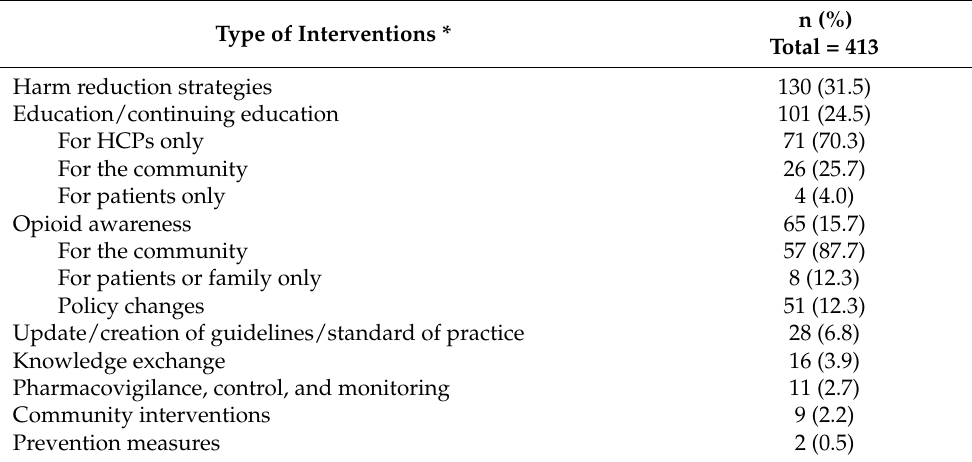
Table 1. Types of opioid risk minimization interventions and policies implemented in Canada (national or provincial) between 2016 and